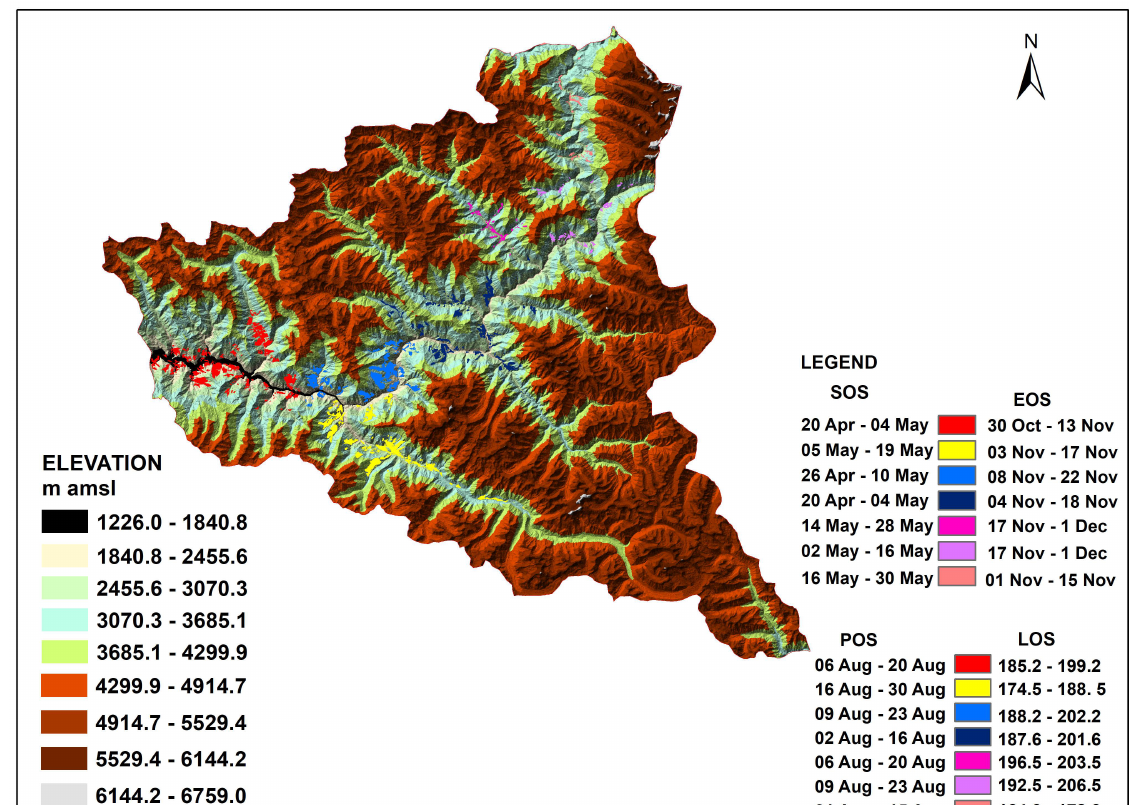
Figure 6. Seasonality variations in plantation land use in the